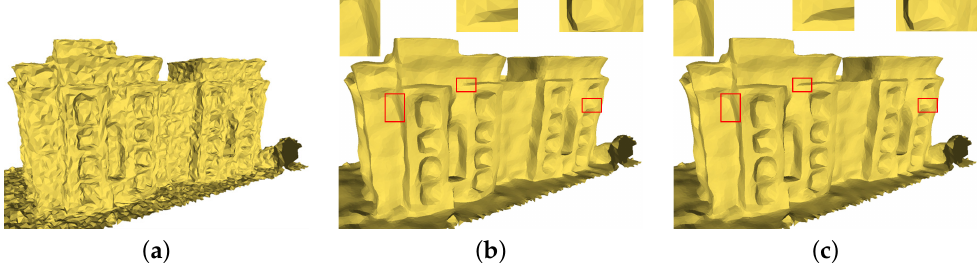
Figure 5. Comparison results for non-feature point updating: ( a ) noisy model; ( b ) the result without isotropic neighborhoods; and ( c ) our result with isotropic